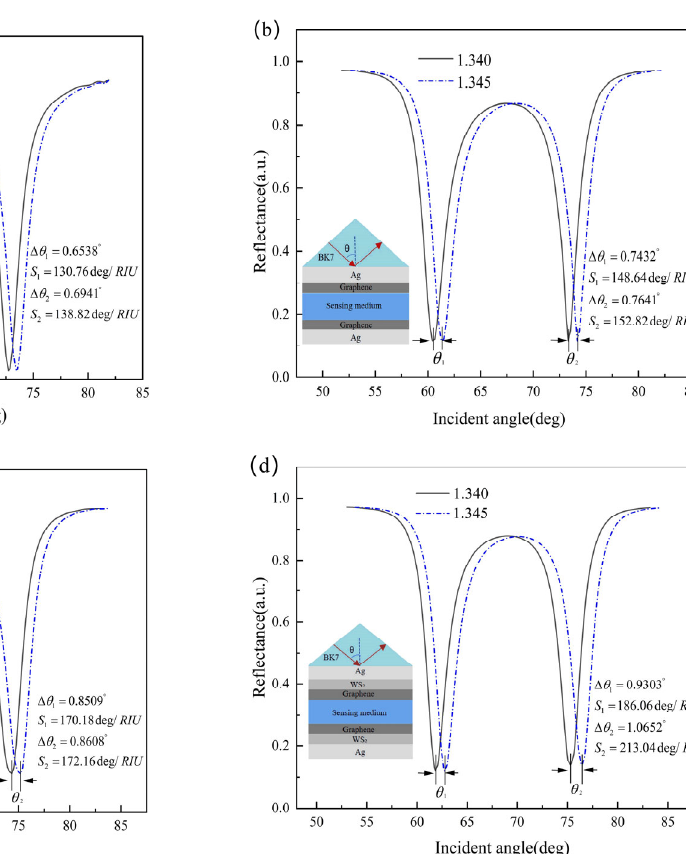
Figure 4. The reflectance and incident angle varied with ws 2 and graphene for the same gradient change in RI: ( a ) only the 40 nm silver layer configured (W = 0, G = 0); ( b ) configured with the 40 nm silver and the monolayer of graphene (W = 0, G = 1); ( c ) configured with the 40 nm silver and the monolayer of WS 2 (W = 1, G = 0); ( d ) simultaneous configuration of 40 nm silver, the monolayer of WS 2 and graphene (W = 1, G = 1).